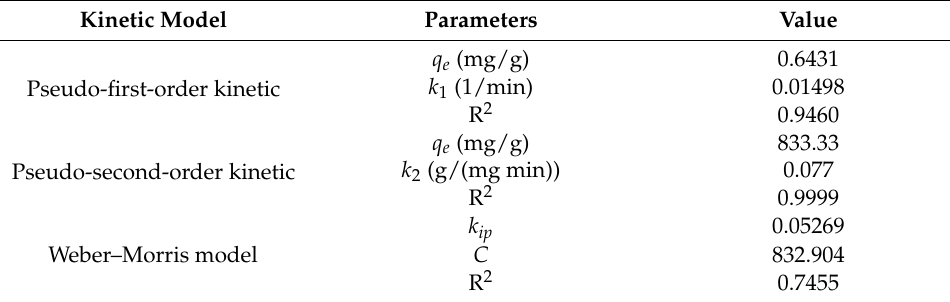
Figure 1. SEM images of ( a ) GA. ( b ) GO. Table 2. Parameters of kinetic models for MB adsorption.